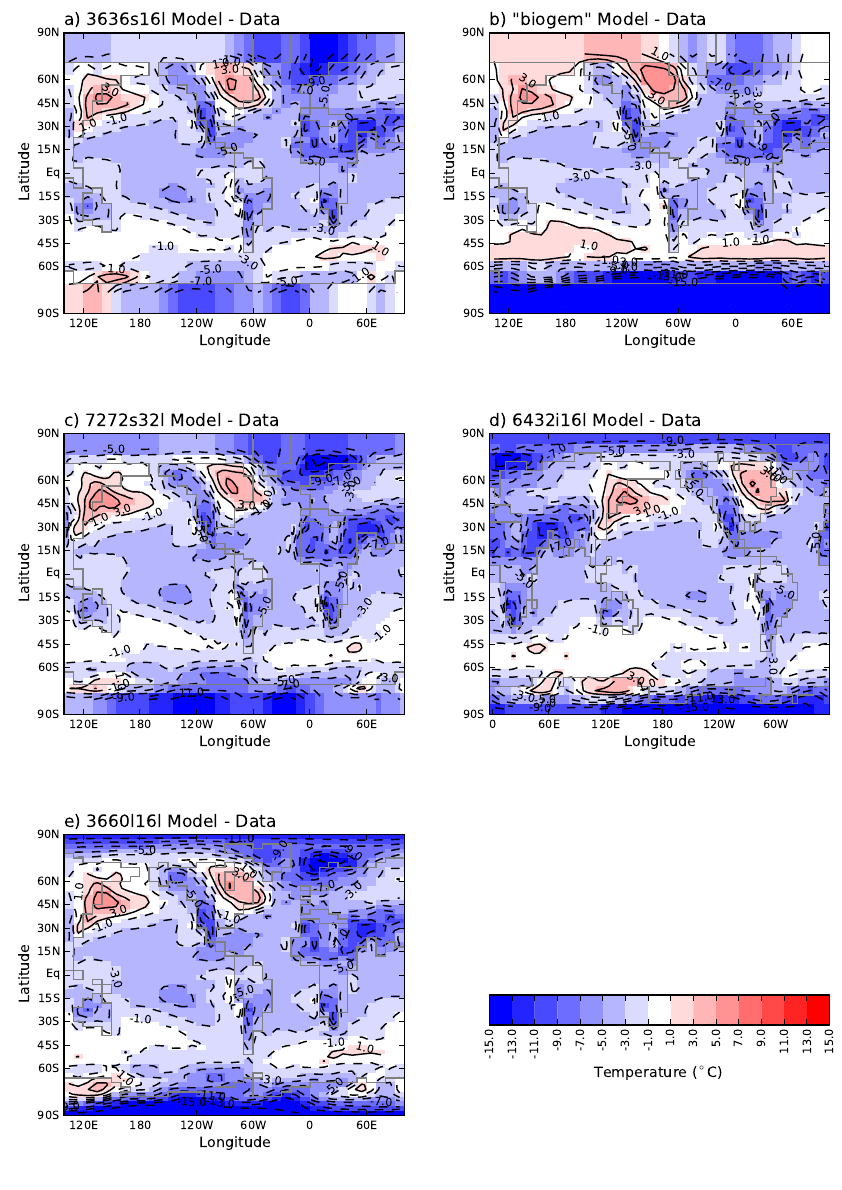
Fig. 8. Annual-mean “model minus observation” differences of surface air temperature, for the five experiments. Observation-based fields are long-term averages of 1000mb temperature fields from the NCEP/DOE 2 reanalysis (Kanamitsu et al., 2002).